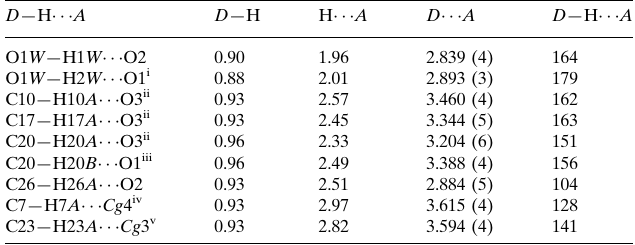
Hydrogen-bond geometry (A˚ , (cid:3) ). D —H (cid:1)(cid:1)(cid:1)